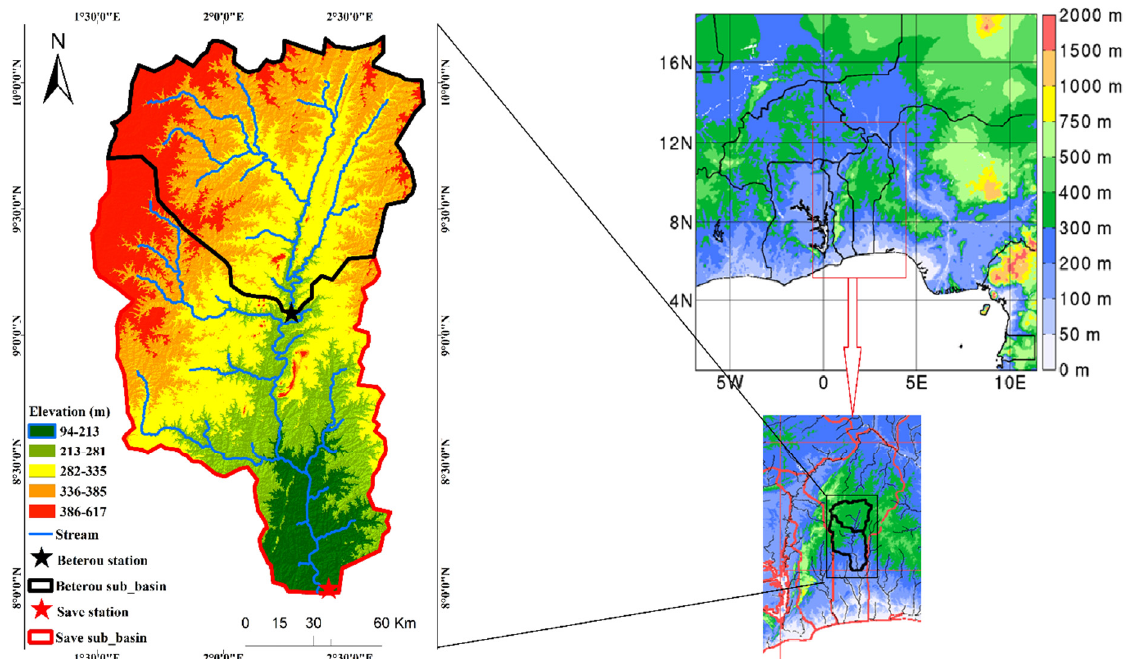
Figure 1. Weather Research Forecast (WRF) and WRF/WRF-Hydro simulated domain, and studied catchments (Savè and Bétérou).